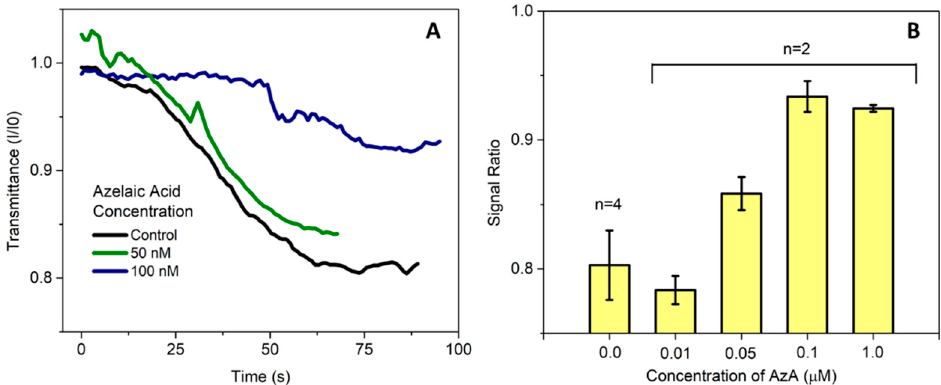
Figure 2. ( A ) Measurement of the microcolumn transmittance acquired in real time by the thin-film silicon photodiodes. The transmission values are presented as a ratio between the current at each time point and the initial value of measurement before introducing the sample; ( B ) Average value for endpoint measurements presented as the ratio between the final and initial current measured by the photodetector. Currently, the limit of detection of AzA in buffer in this system is approximately 50 nM.